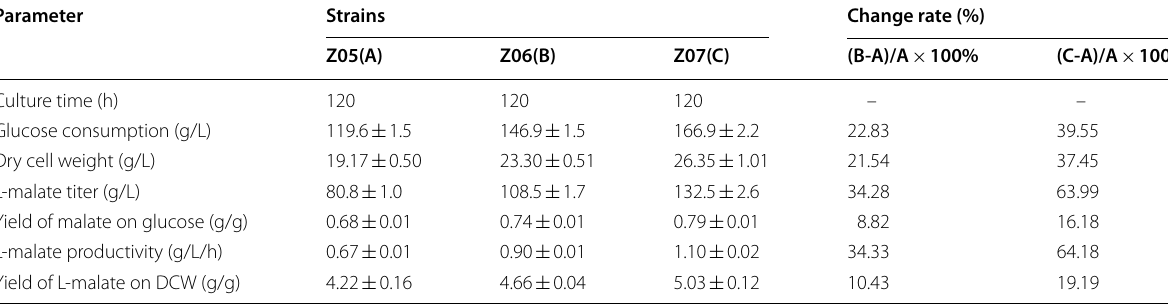
The numbers stated are means of three individual experiments